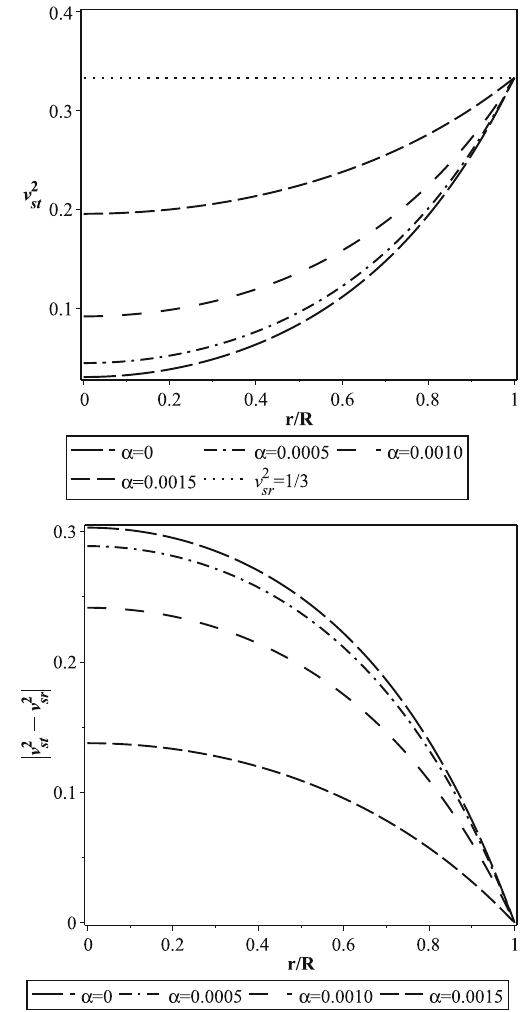
Fig. 10 Variationof(i) v 2 sr and v 2 st (upperpanel)and(ii) | v 2 st − v 2 sr | ≤ 1 (lower panel) as a function of the radial coordinate and decrease monotonically through out the system to reach the minimum value at the surface and confirms regularity of the achieved solutions. We have predicted different values of the central density, ρ c and central pressure p c for the differ- ent strange star candidates in Table 1. We find that the den- sities and radial pressures of the different strange stars are in the order of 10 14 gm / cm 3 and 10 34 dyne / cm 2 ,